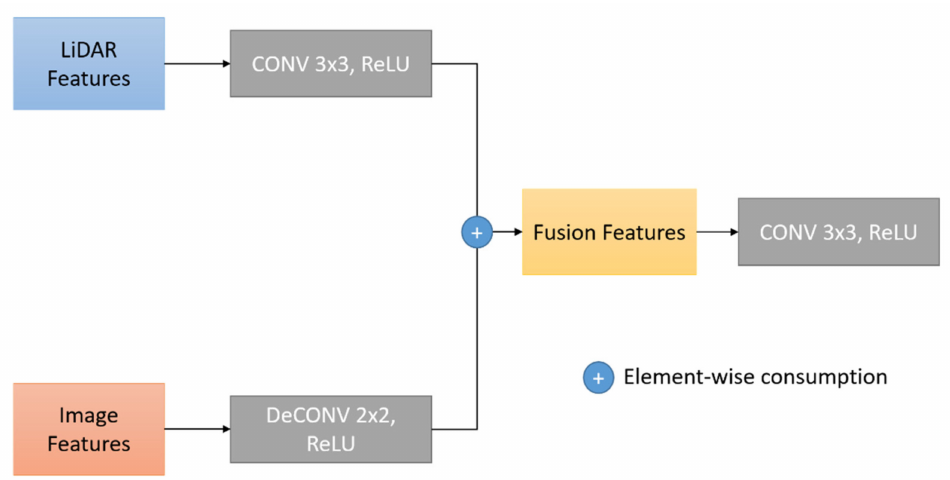
Figure 3. The fusion module